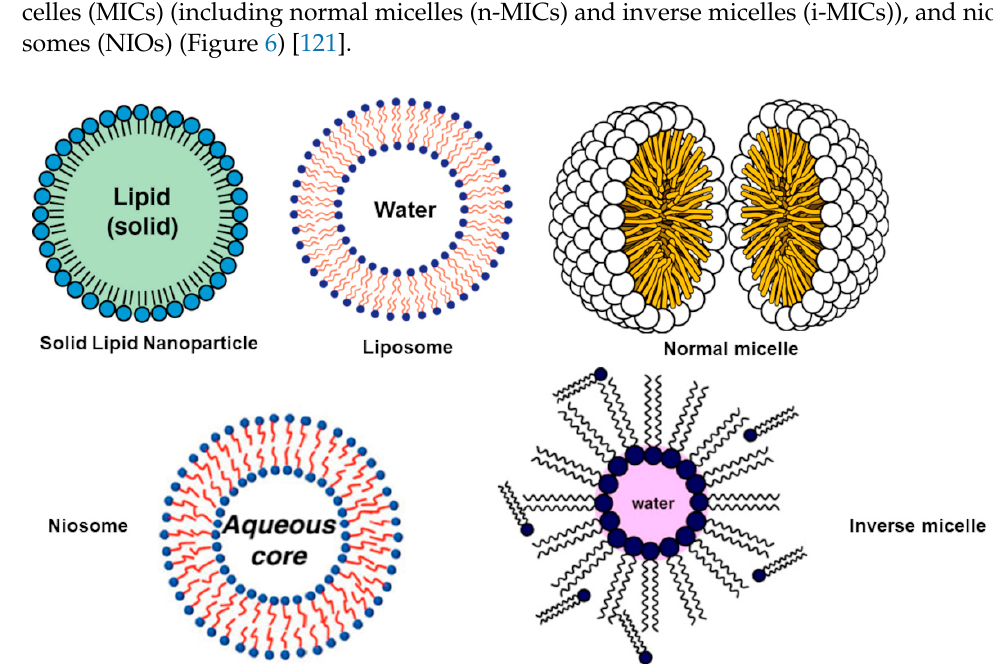
Figure 6. Examples of lipid-based NPs.